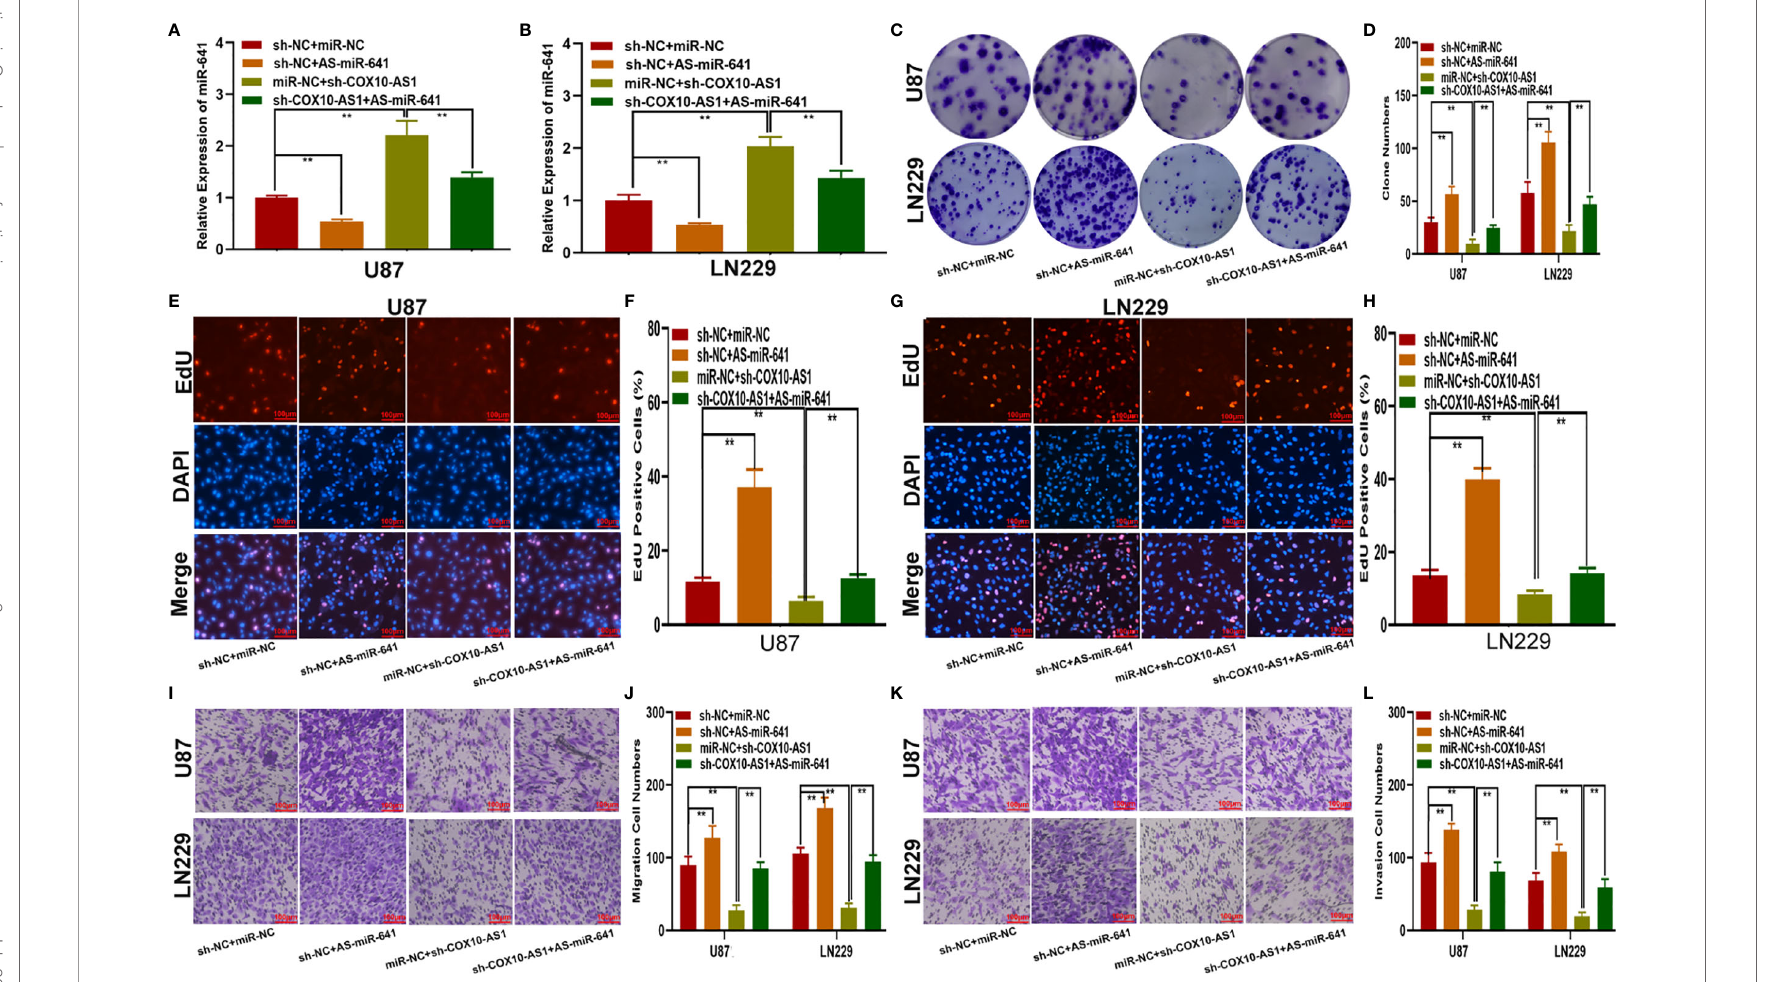
FIGURE 5 | The effect of COX10-AS1 on glioma is partially mediated by miR-641. (A, B) The relative expression of miR-641 in U87 and LN229 transfected with miR-641 inhibitor, sh-COX10-AS1 or the corresponding controls, as measured by qRT-PCR. (C, D) The proliferation of U87 and LN229 cells transfected with miR-641 inhibitor, sh-COX10-AS1 or the corresponding controls, as measured by clone formation assays. (E – H) The proliferation of U87 and LN229 cells transfected with miR-641 inhibitor, sh-COX10-AS1 or the corresponding controls, as measured by EdU assays. (I, J) The migration of U87 and LN229 cells transfected with miR-641 inhibitor, sh-COX10-AS1 or the corresponding controls, as measured by Transwell assays. (K, L) The invasion of U87 and LN229 cells transfected with miR-641 inhibitor, sh-COX10-AS1 or the corresponding controls, as measured by Transwell assays. **P <